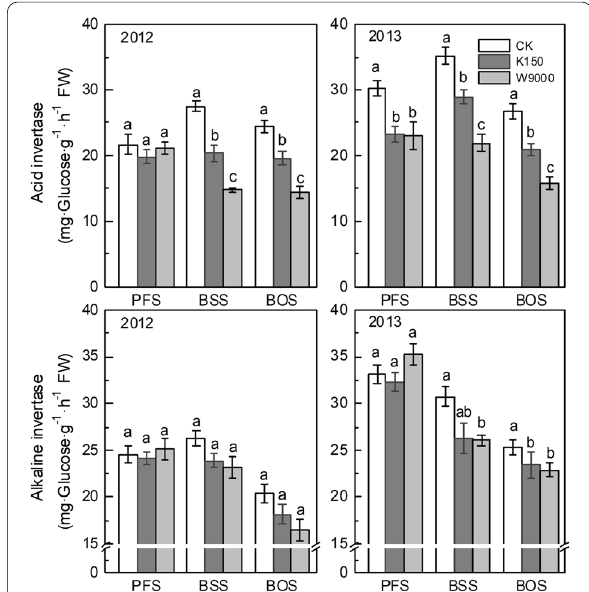
Fig. 7 Effects of straw-returning and inorganic K fertilizer on acid and alkaline invertases activities in the functional leaf at the Fig. 6 Effects of straw-returning and inorganic K fertilizer on sucrose peak flowering (PFS), boll-setting (BSS) and boll-opening (BOS) phosphate synthase (SPS) and sucrose synthase (SuSy) activities in stages of Siza 3 in 2012 and 2013. The data are means of three the functional leaf at the peak flowering (PFS), boll-setting (BSS) and replications standard error. For each growth stage, bars bearing boll-opening (BOS) stages of Siza 3 in 2012 and 2013. The data are ± different letters are significantly different at P means of three replications standard error. For each growth stage, = ± bars bearing different letters are significantly different at P 0.05 =